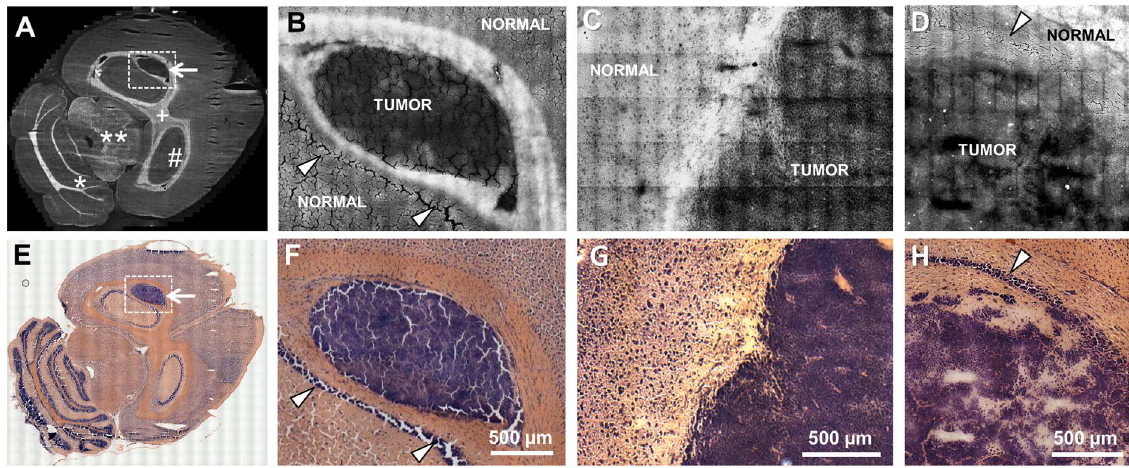
Figure 1. Imaging of experimental human glioblastoma and brain metastases in a mouse model. A : CARS image of a whole mouse brain section with an experimental human U87MG glioblastoma; white matter tracts appear brighter in the CARS image, while the tumor (arrow) is darker that the normal brain tissue. # hippocamus, + corpus callosum, **mesencephalon, *cerebellum B : Magnified CARS image of the area indicated in A; the difference in the CARS signal intensity between the neoplastic tissue and the surrounding white matter enables discerning the tumor border. C : CARS image of a breast cancer metastasis (induced by MCF-7 cells) in a mouse brain. D : CARS image of a metastasis of melanoma (induced by A375 cells) in the hippocampal region of a mouse brain. E–F : H&E stainings of consecutive sections corresponding to A–D. The arrowheads indicate nuclei- rich layers in gray matter of the hippocampus.